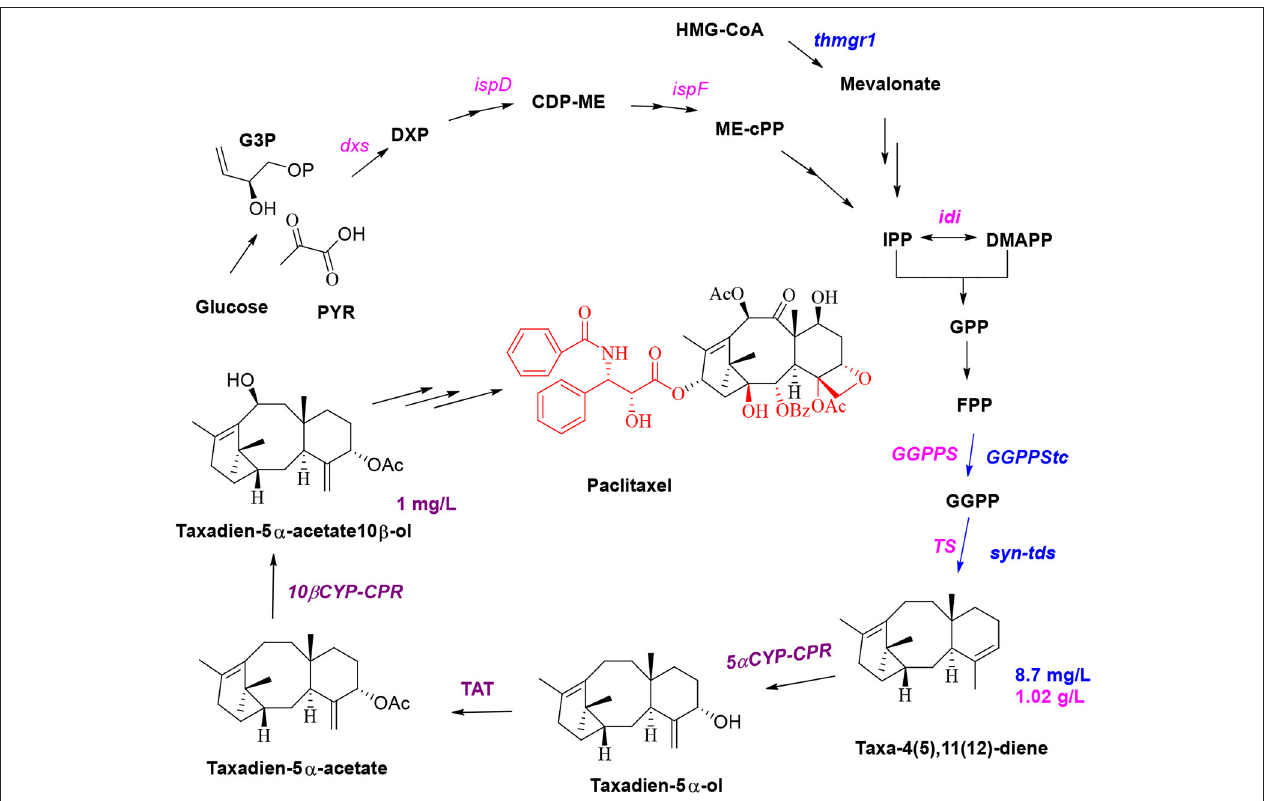
FIGURE 3 | Optimization of the production of the paclitaxel